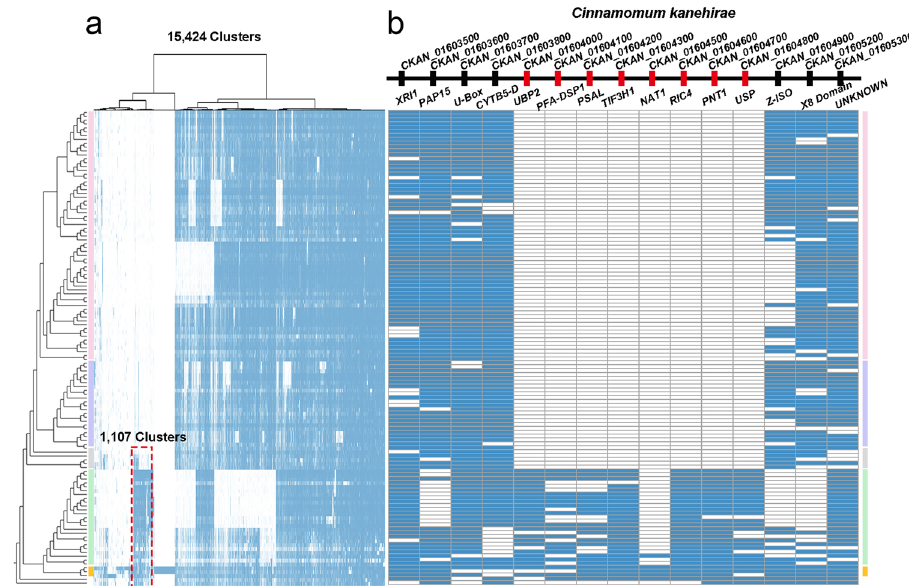
Fig. 6 Magnoliids-associated signals and a representative example of phylogenetically informative microsynteny. a Hierarchical clustering (method: ward.D) of 15,424 magnoliids-associate cluster pro fi les based on Jaccard distance. On the far-left, the synteny-based species tree is displayed (same as Fig. 4). Superrosids, superasterids, early diverging eudicots, monocots, and magnoliids are shaded in light-red, light-purple, light-grey, light-green, and light- yellow, respectively. 1107 clusters supporting a grouping of magnoliids and monocots (Supplementary Data 5). b One example from all supporting signals. A fi fteen-gene context in the genome of Cinnamomum kanehirae (a magnoliid) shows eight neighboring genes (highlighted in orange) only present in magnoliids and monocot genomes, while the fl anking genes (colored blue) are generally conserved